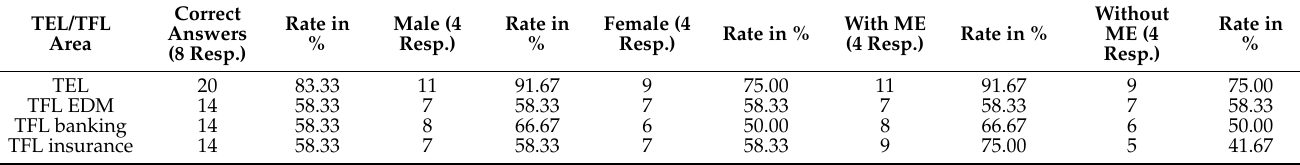
Table 2. Response